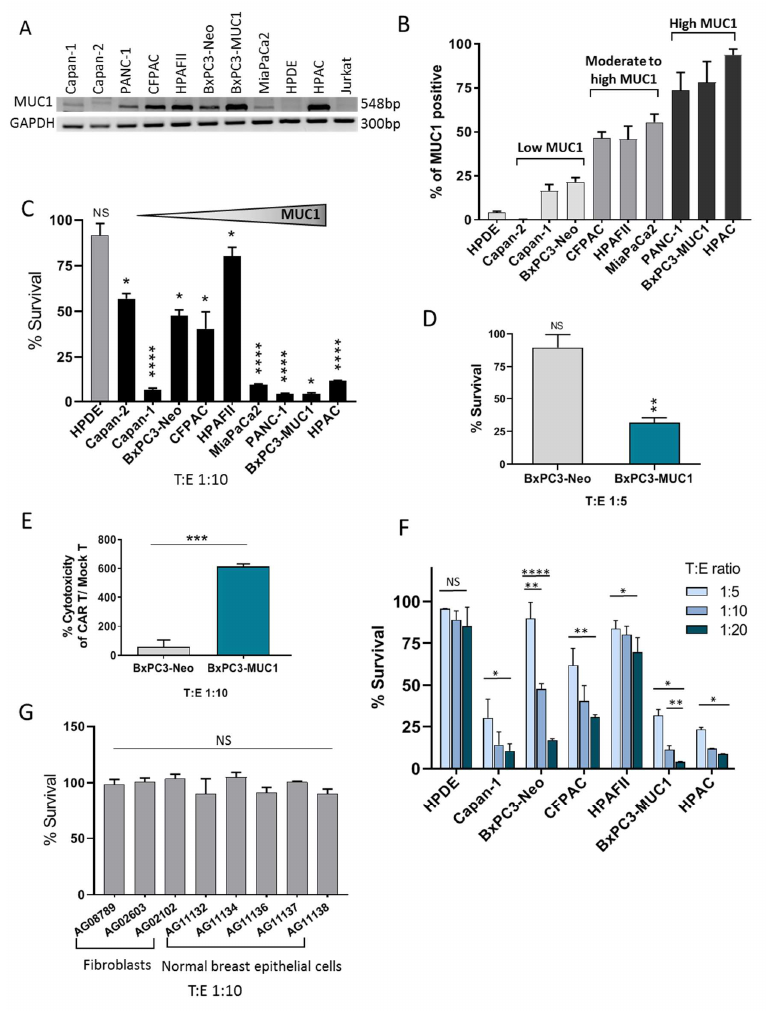
Figure 2. tMUC1-CAR T cells show robust cytotoxicity against PDA cells but not normal cells. ( A ) mRNA levels of human MUC1 in a panel of PDA cell lines acquired by RT-PCR. Jurkat cell mRNA was used as negative control. ( B ) Surface MUC1 expression in a panel of PDA cell lines detected by TAB004 Ab staining and flow cytometry. Cancer cells were categorized into three groups according to their MUC1 level. ( C ) Percentage survival of nine PDA cell lines when treated with CAR T cells measured by MTT assay. Percentage survival of cancer cells treated with CAR T cell was normalized to the mock T cell (uninfected). Cancer cells are ordered from low to high MUC1 (left to right). HPDE cell was used as normal control cell line. All PDA cells show a significant reduction in survival after treatment with CAR T cells. T:E ratio of 1:10 and 72 h incubation was applied to all cell lines. ( D ) The percentage survival of BxPC3-Neo and BxPC3-MUC1 treated with CAR T cells for 72 h at T:E ratio of 1:5. BxPC3-Neo stays intact when treated with low dose of CAR T cells (T:E 1:5), while BxPC3-MUC1 is e ff ectively killed. ( E ) Spontaneous killing of BxPC3 cells by CAR T cells within 24 h measured by an LDH-based technique, Cytotox assay. CAR T cells show significantly higher levels of cytotoxicity against BxPC3-MUC1 cells compared to BxPC3-Neo cells. ( F ) The percentage survival of PDA cells and normal pancreatic epithelial cell line (HPDE) when treated with increasing doses of CAR T cells. Data shows that CAR T cell killing is dose dependent. By increasing the dose of CAR T cells, more killing was observed in PDA cells, while the survival of normal cell (HPDE), even at T:E of 1:20, remained unchanged. ( G ) The percentage survival of a panel of human normal primary cells, including fibroblasts and breast epithelial cells, obtained from healthy donors treated with CAR T cells for 72 h at T:E 1:10. There is no significant reduction in the survival level of normal primary cells when treated by CAR T cells. All data presented was normalized to mock T cell. Two-way ANOVA-multiple comparisons and Student’s t -test were performed for determining significance. Error bars, SEM. n = 4. * p < 0.05, ** p < 0.01, *** p < 0.001, **** p <